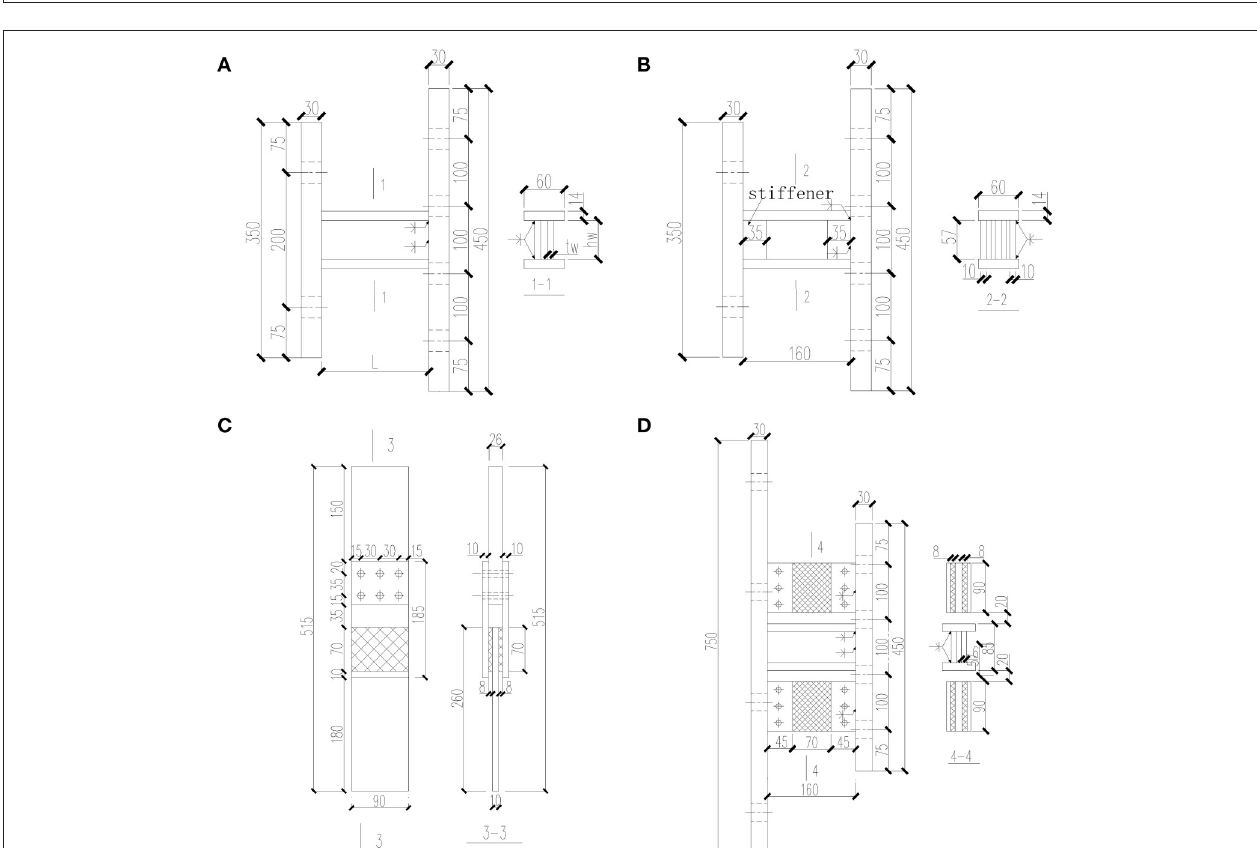
FIGURE 2 | Test specimens: (A) metallic dampers M1–M7; (B) metallic damper M8; (C) VE damper; (D) combined damper. standardized mild steel with the yield strength of 345 MPa, is in Figure 2 . For the metallic damper, the variable parameters used for flanges. For the web, three types of steel, LY160 (low studied are the steel grade, dimensions of the web, and yield point steel with a nominal yield stress of 160 MPa), LY225 end stiffener configuration. Q345 steel, one kind of Chinese